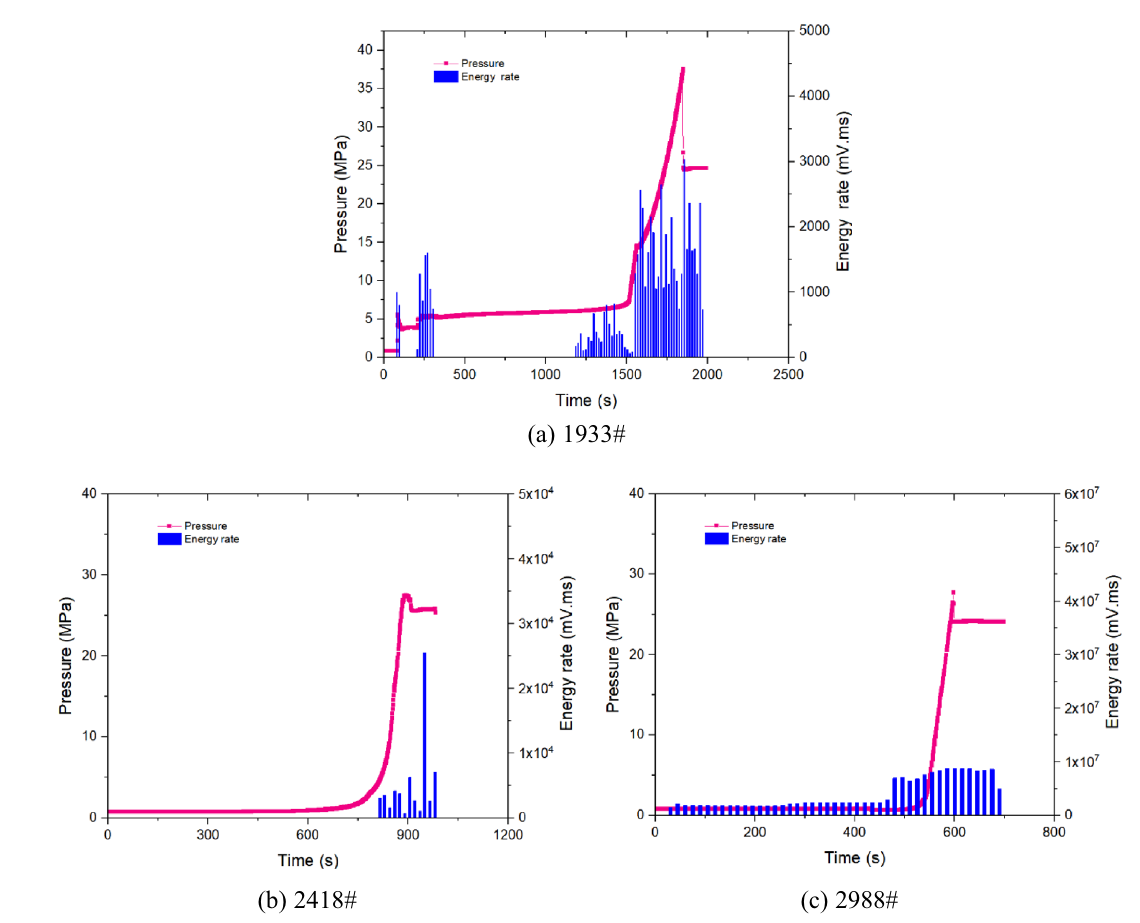
Fig. 14 Pump pressure curves of the specimen with the injection rate of 4.8